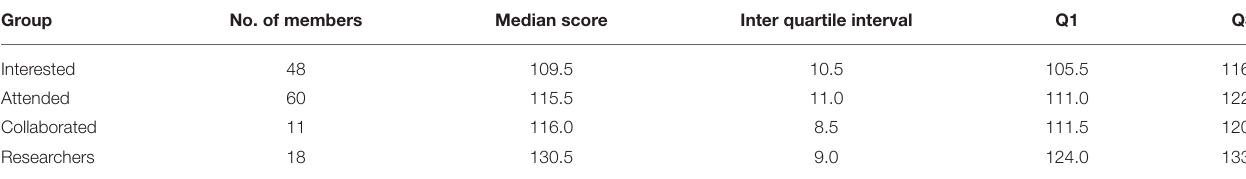
TABLE 1 | Group composition and descriptive parameters of the neuromyth survey results.